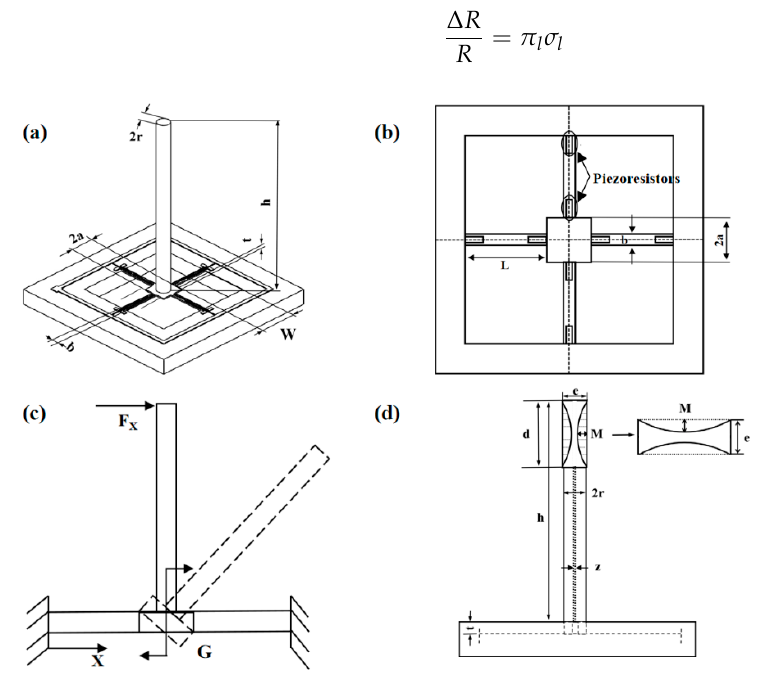
Figure 2. ( a ) Micro-structure model for the sensor. ( b ) Model for piezoresistor on beams. ( c ) Mechanical analysis of the micro-structural model. ( d ) Micro-structure model of the hollow-concave cilium. In Formula (4), σ l means the longitudinal stress on each piezoresistor, π l refers to the longitudinal piezoresistive coefficient of each piezoresistor. With Formulas (3) and (4), the output voltage is proportionally correlated with the variation in piezoresistors’